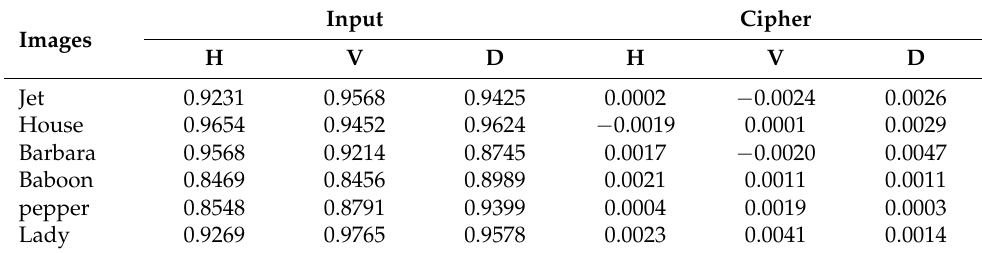
Table 2. Correlation results for the input and cipher images.